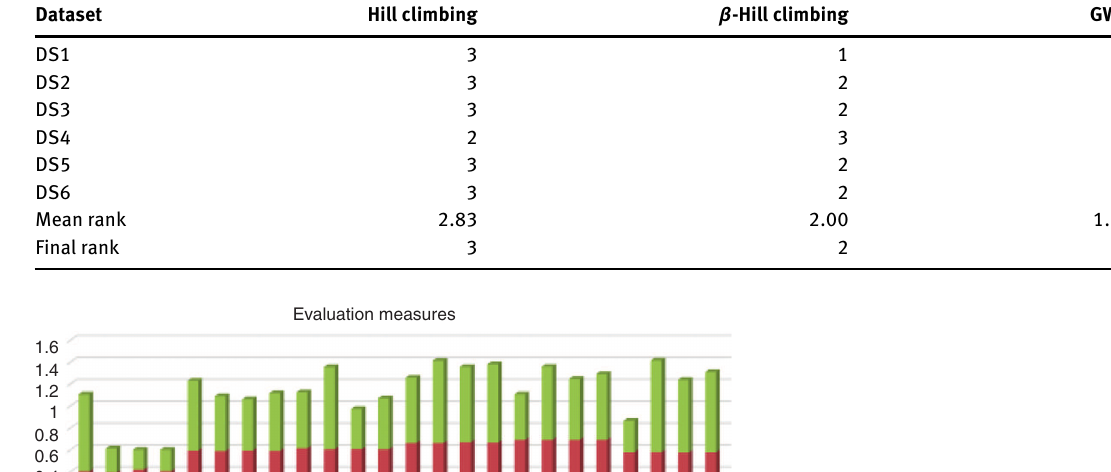
Table 5: Statistical analysis based on F-measure values. Dataset